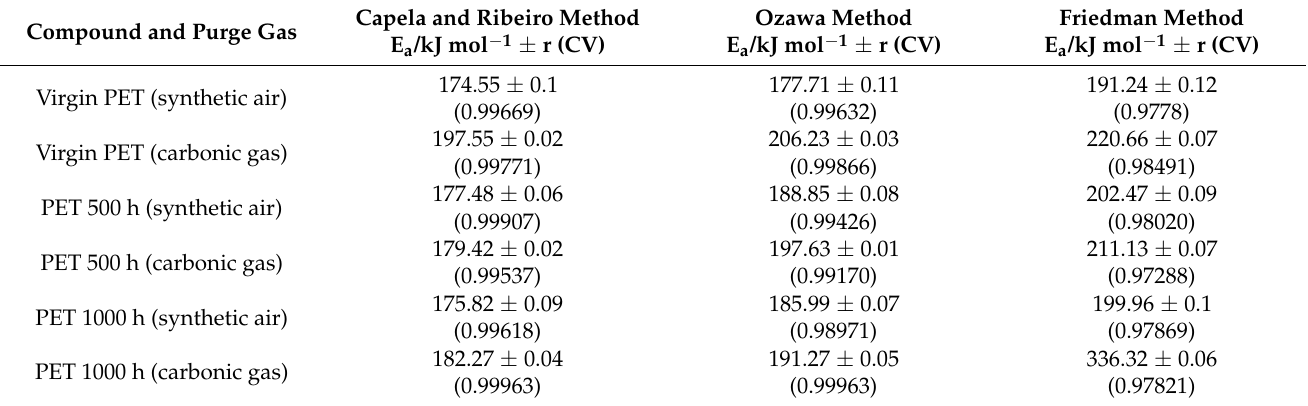
Table 2. Activation energy values using the Flynn–Wall–Ozawa, the Capela/Ribeiro and the Fried- mann methods. The data were obtained with the arithmetic mean (r is the correlation value and CV is the coefficient of